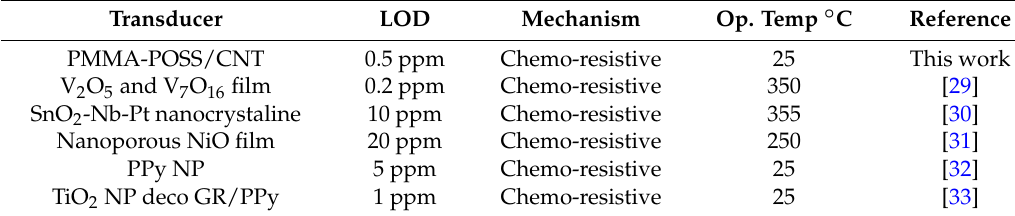
Table 1. Ammonia sensing performances of some nanocomposite sensors, Op.: